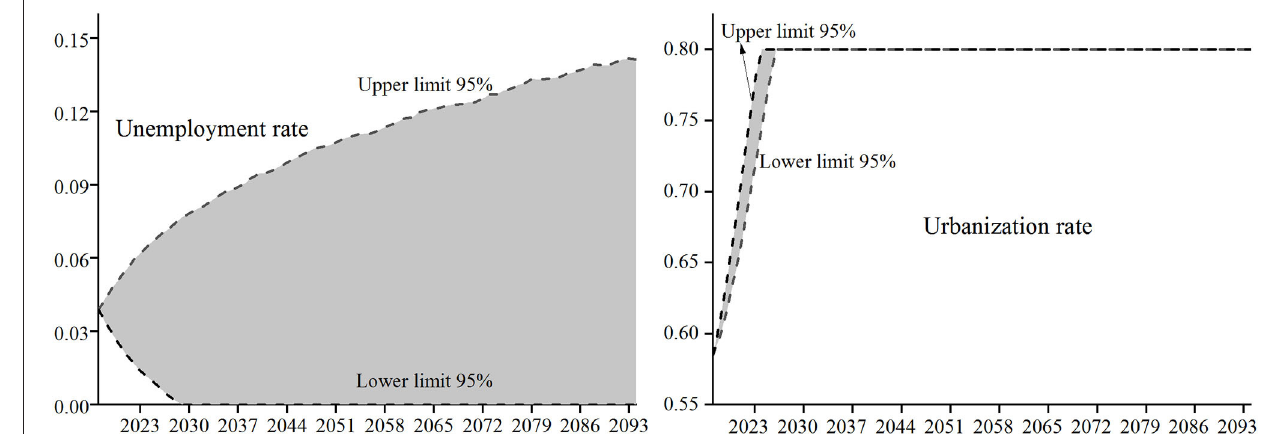
FIGURE 1 | Simulated distribution of unemployment rate and urbanization rate. seen that the standard deviation of this distribution is 0.0153, so the c t follows the normal distribution of N (0.08,